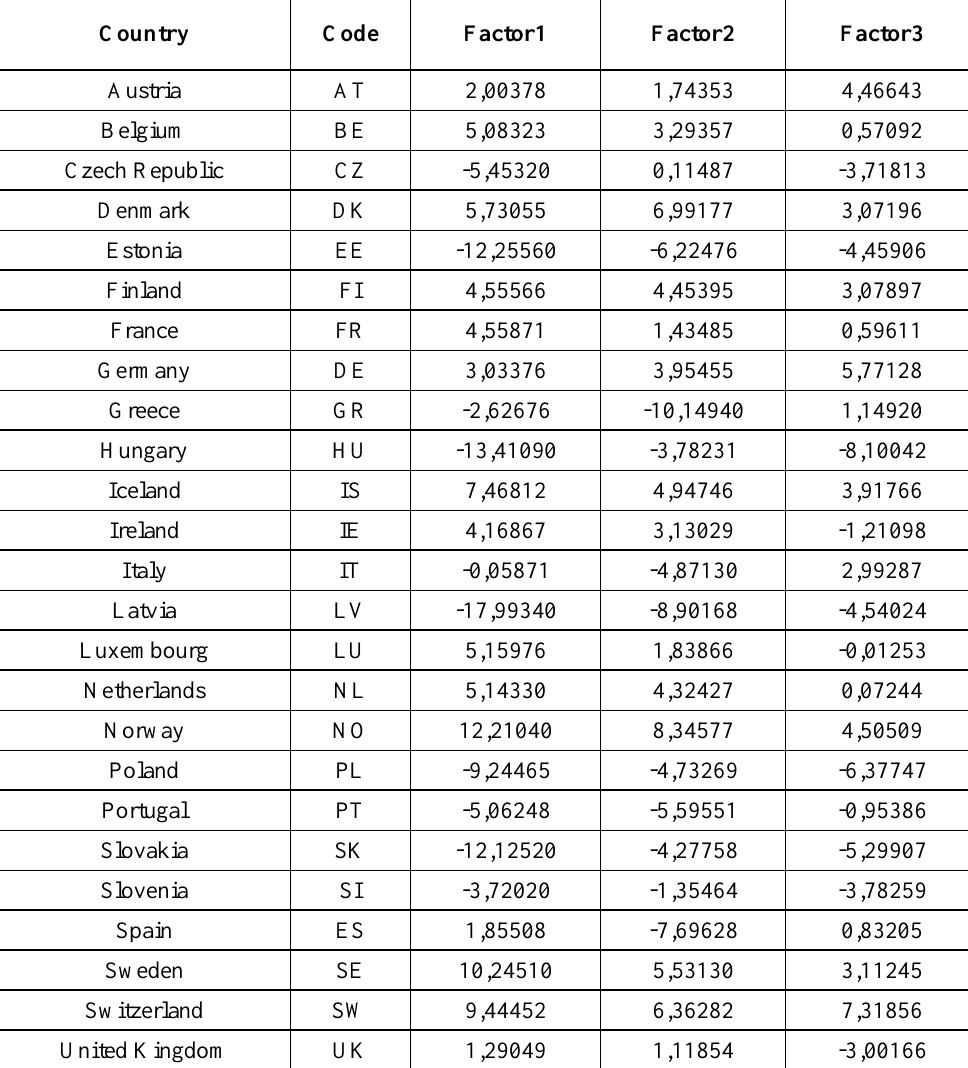
Table 3. Table of Factor